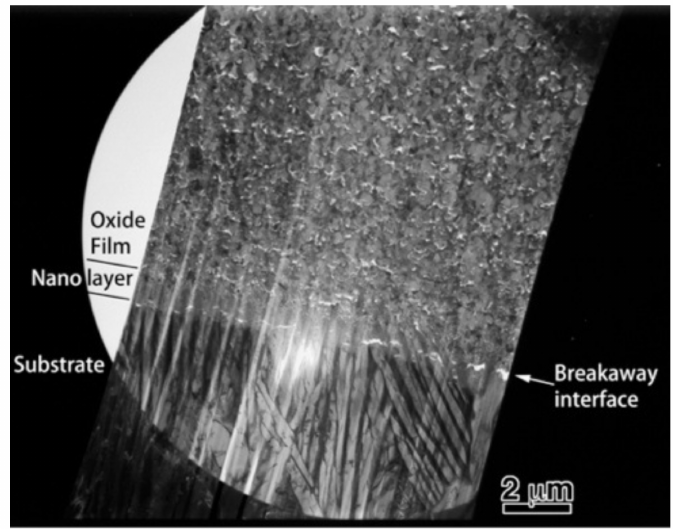
Figure 10. Low-magnification TEM image of a cross-section of oxidized Ti–29Nb–13Ta–4.6Zr. The oxidation conditions at 1273 K for 1.8 ks in air.